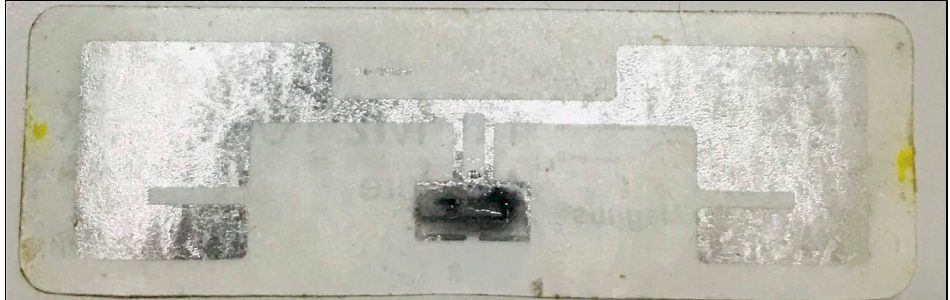
Figure 4. Photograph of MPGE smart tag.